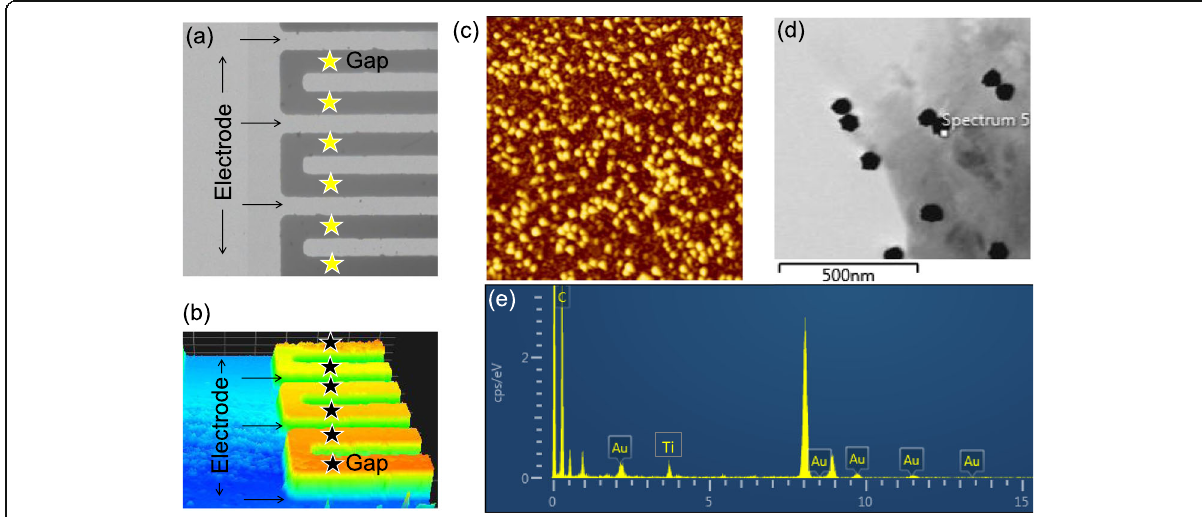
Fig. 2 a High-power microscopy image on IDE surface. Images were captured at × 50. b 3D nanoprofiler image on IDE surface. Images were captured at × 50. Electrode and gap regions are shown. The gaps are indicated by stars. Uniform arrangements indicate the successful fabrication.